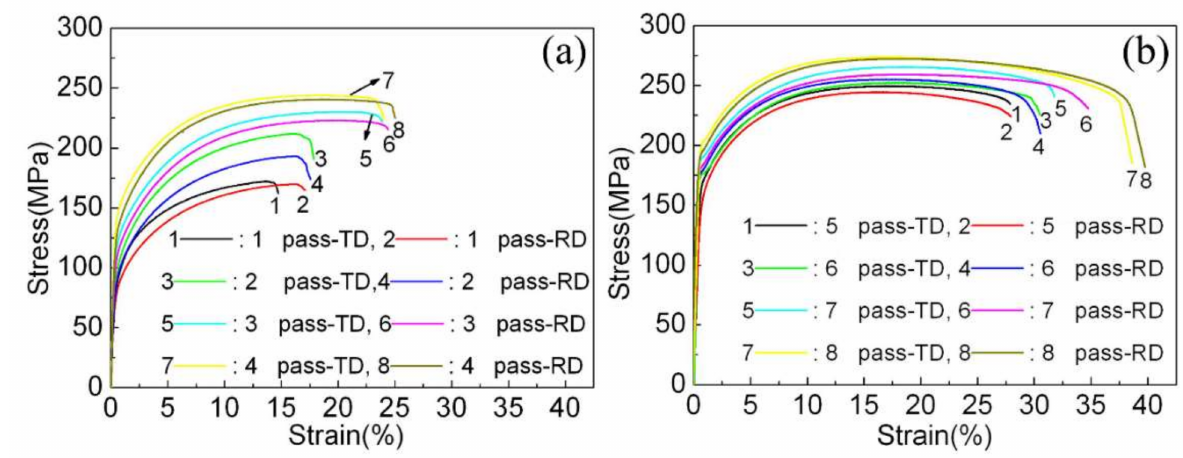
Figure 7. Microstructure characteristics using inverse pole figure maps for the ( a ) Pass 4 sheet and ( b ) Pass 8 sheet.